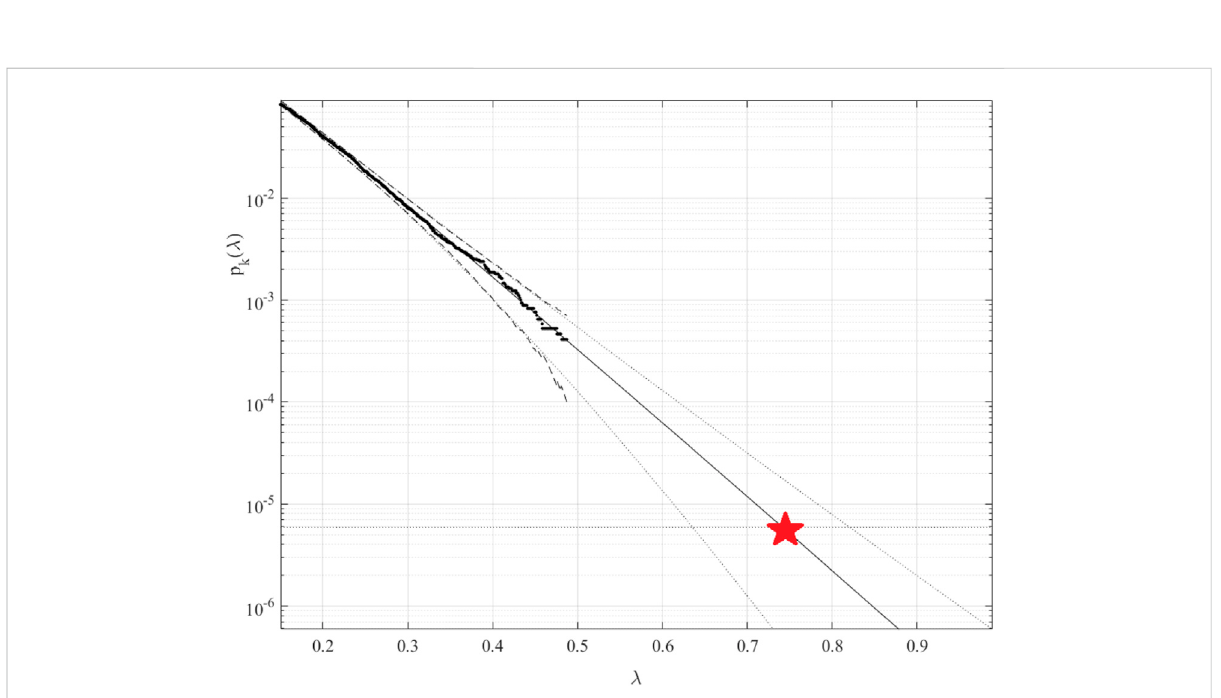
Extrapolation of p k ( λ ) towards critical level corresponding to 100 years return period (indicated by a star) and beyond, k (cid:2) 6 . The extrapolated 95% CI is indicated by dotted